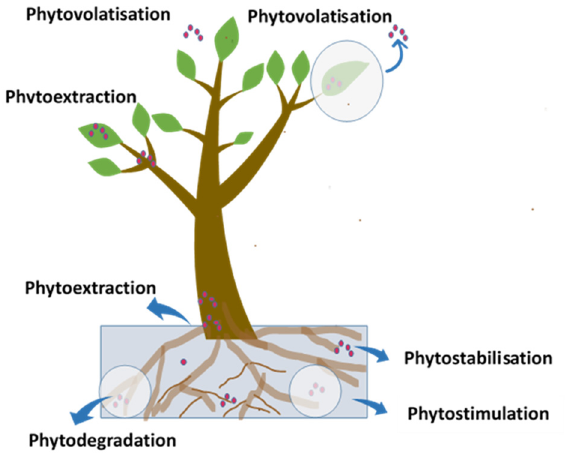
Figure 3. Schematic representation of phytoremediation techniques.